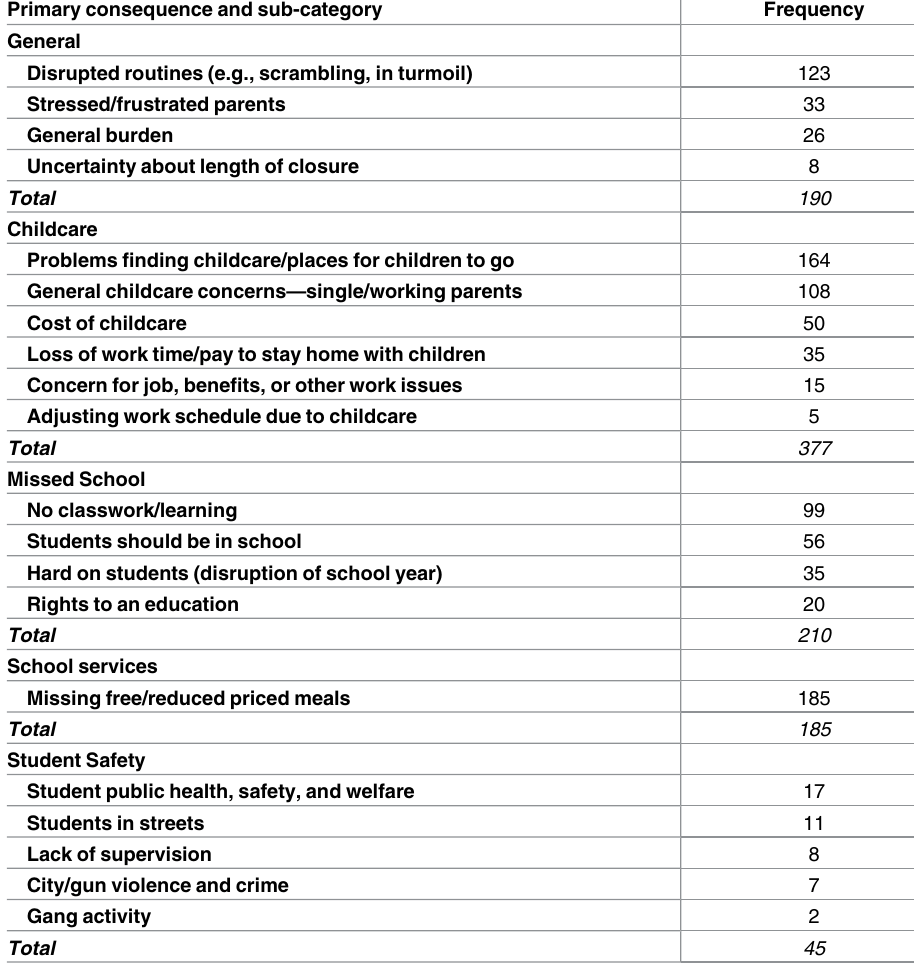
Table 2. Costs and consequences abstractedfrom 619 social media posts expressing negative sen- timent. Each post could express up to three costs and consequences. Posts captured from social media referencingChicagoteachers’ strike from September 8–21, 2012 (two days before to three days after